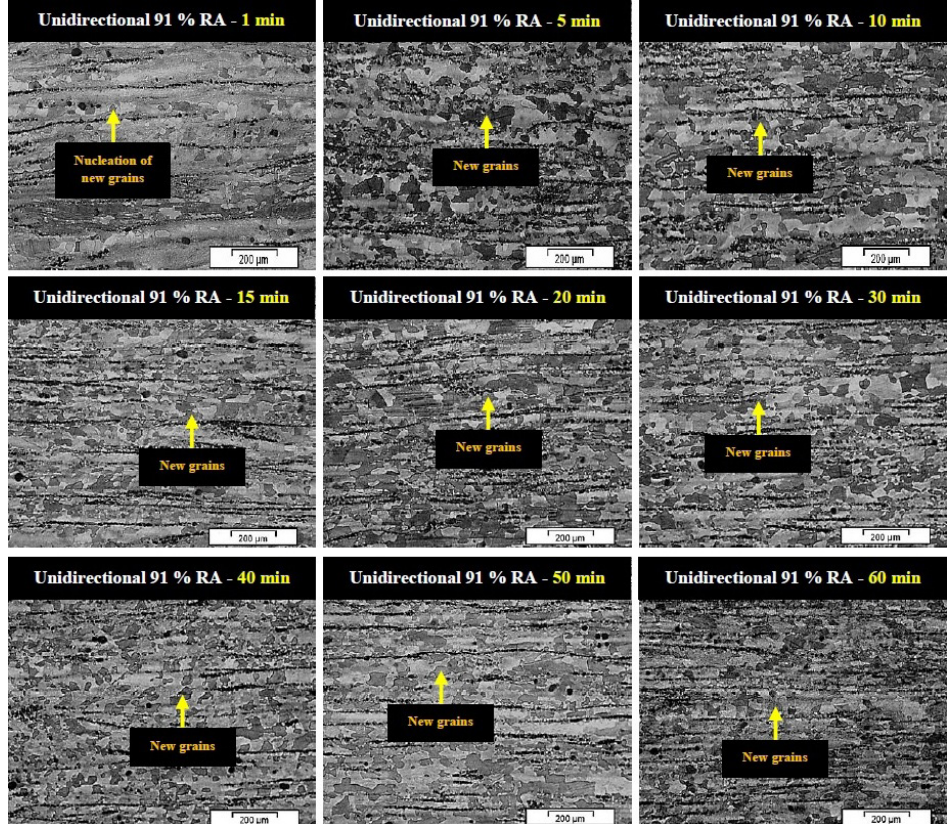
Figure 9. Recrystallization kinetics at 350 ºC of the Al4.5wt%Cu sample with 91% of RA unidirectionally solidified.